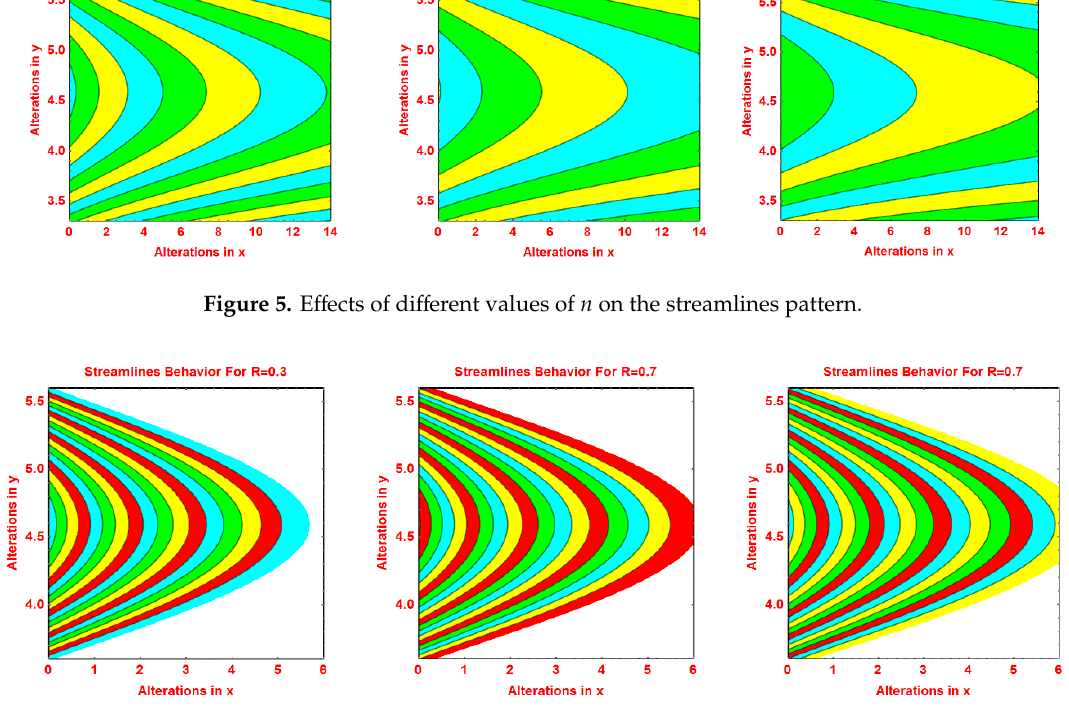
Figure 6. Effects of different values of R on the streamlines pattern.